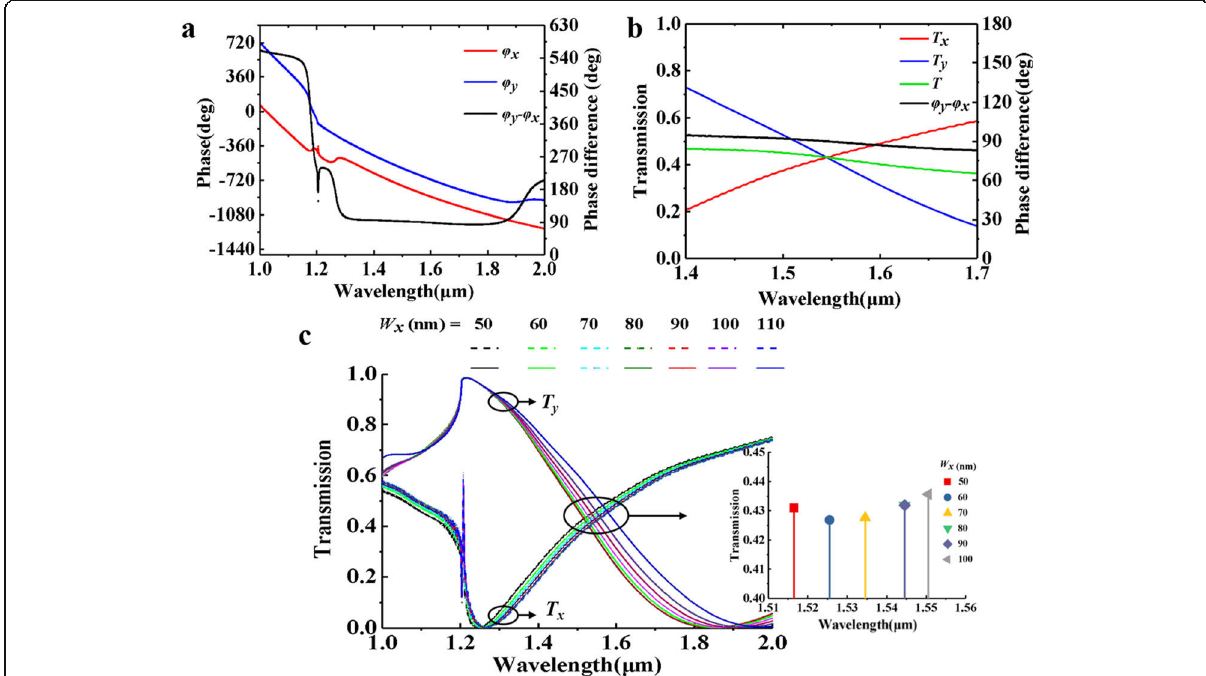
Fig. 2 Simulation results of the proposed structure. a The phase of T x , T y and there difference when W x = 100 nm. b Transmittance T , T x and T y , and the phase difference of the two transmission lights. c T x and T y curves when W x changes. The small image is the detailed diagram near 1550 nm. It shows the variation trends of T x , T y , total transmittance T , and phase difference at the communication wavelength